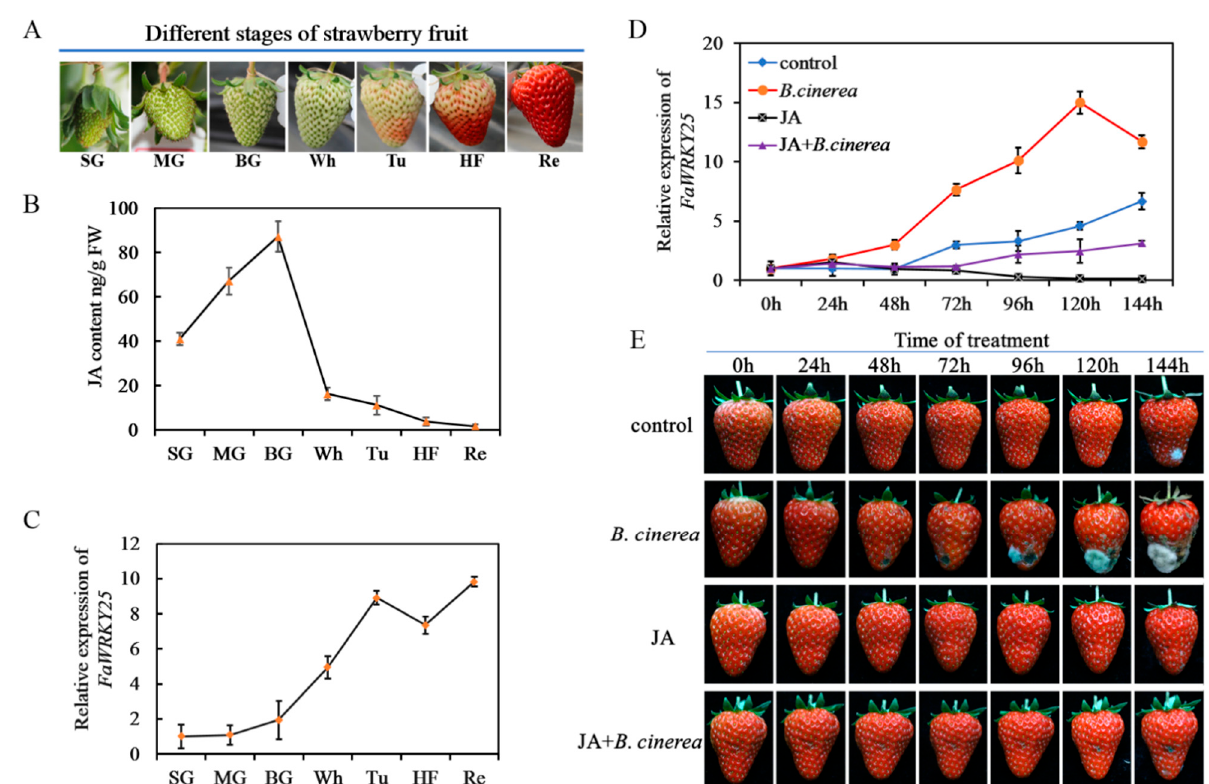
Figure 2. Variation of FaWRKY25 gene expression and jasmonic acid (JA) content in strawberry fruits. ( A ) Phenotypes showing different developmental stages of strawberry fruit: SG (15–20 days after flowering), MG (20–25 days after flowering), BG (25–30 days after flowering), Wh (30–35 days after flowering), Tu (35–38 days after flowering), HF (38–40 days after flowering), and Re (40–45 days after flowering). ( B ) Changes in jasmonic acid levels throughout fruit development. ( C ) Changes in FaWRKY25 gene expression levels throughout fruit development. ( D ) FaWRKY25 relative expression in red fruit under different treatments. ( E ) Phenotypic effects of JA on red fruits after Botrytis cinerea inoculation. Control, fruits treated with sterile water; B. cinerea , fruits inoculated with Botrytis cinerea ; JA, fruits treated with 250 µM JA; JA+ B. cinerea , fruits inoculated with Botrytis cinerea after being treated with 250 µM JA. As for MeJA treatments, the fruits were inoculated with B. cinerea right after being treated with different concentrations of MeJA for 2 hours. The experiment was repeated three times, and 30 fruits were used in each batch for each treatment.